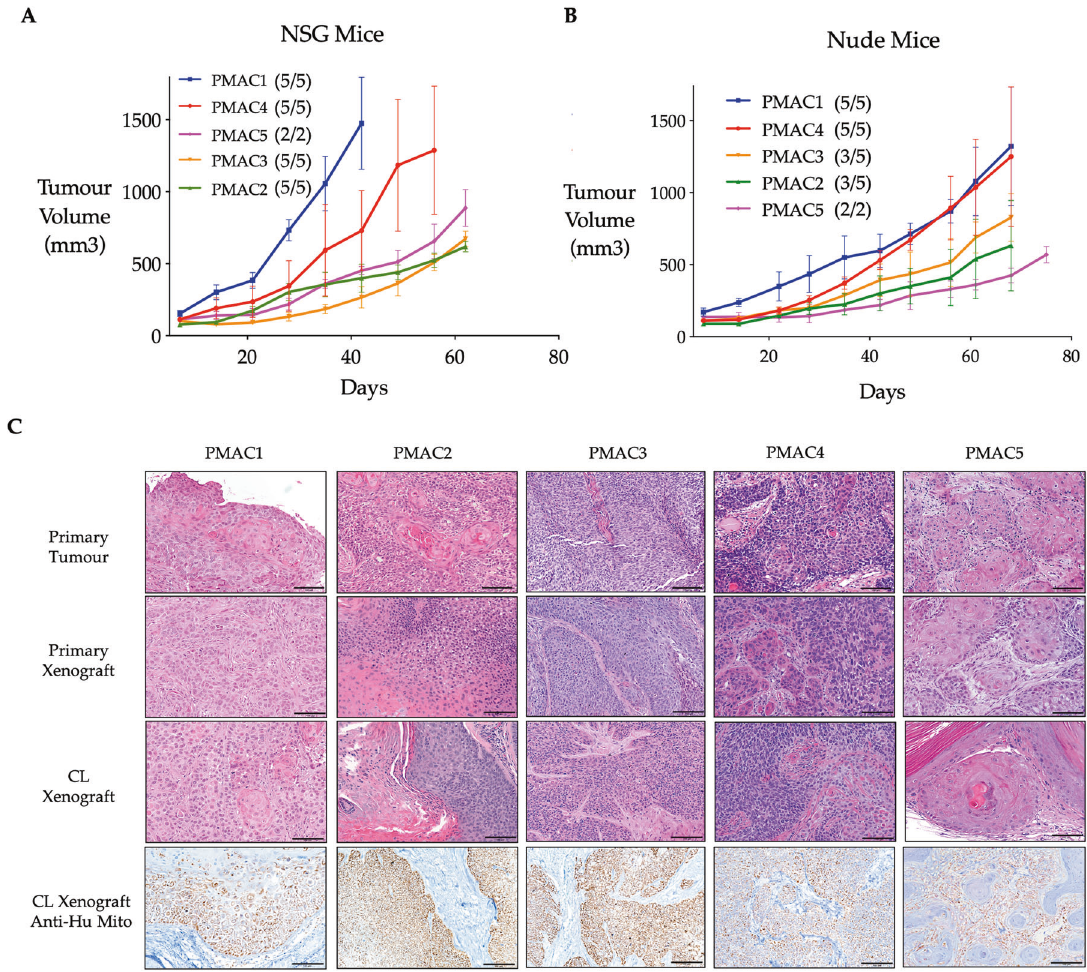
Fig. 3 Characterisation of anal SCC cell lines as xenografts. Tumourigenicity of the fi ve human ASCC lines was assessed in both A NSG and B athymic (Nude) mice following subcutaneous injections of 5 × 10 6 cells in 100 μ l of 1:1 Matrigel:PBS. The tumours were measured with the growth demonstrated (Mean ± SEM) of those mice with tumours for each cell line. The proportion of mice developing established tumours is displayed in the key. C Histological architecture of the fi ve human ASCC tumours and the derived tumour models following formalin fi xation, paraf fi n embedding, sectioning and staining (Scale bar 100 μ m). The haematoxylin and eosin images demonstrate preservation of the cellular and architectural features of the human ASCC tumours from which the primary and cell line xenografts were subsequently derived. Anti- human mitochondrial immunohistochemistry demonstrates staining of the human epithelial tumour cells, with absent staining of the mouse stroma, validating the mouse cell line tumours as human in origin. CL, cell line; Anti-Hu Mito, anti-human